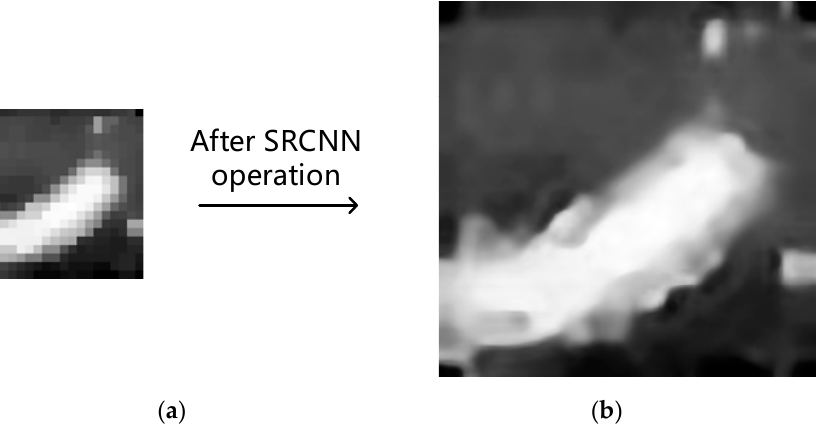
Figure 7. ( a ) Before the SRCNN operation. ( b ) After the SRCNN operation.